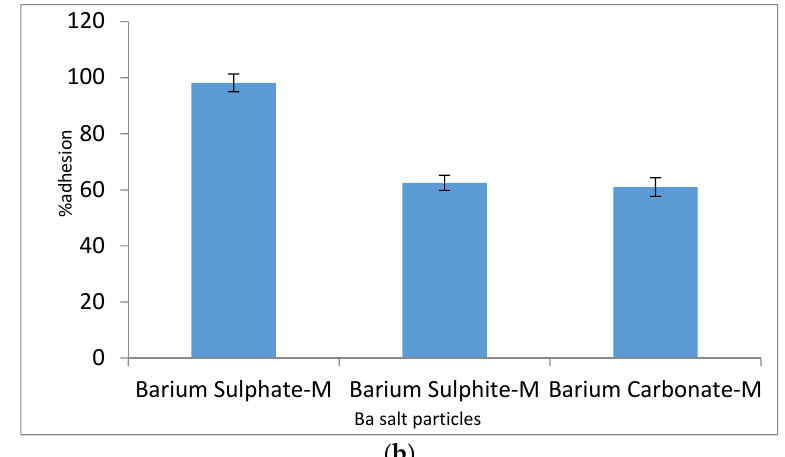
Figure 12. Mucin adhesion efficiency of Ba salt particles. ( a ) The standard curve with absorption vs. known amounts was obtained from solutions of different amounts of mucin (25–600 µg). ( b ) % mucin adhesion of particles was calculated from the absorbance of an unknown sample. BaSO 4 -M: Mucin adhered to BaSO 4 particles; BaSO 3 -M: Mucin adhered to BaSO 3 particles; BaCO 3 -M: Mucin adhered to BaCO 3 particles. Absorbance was read at 595 nm.